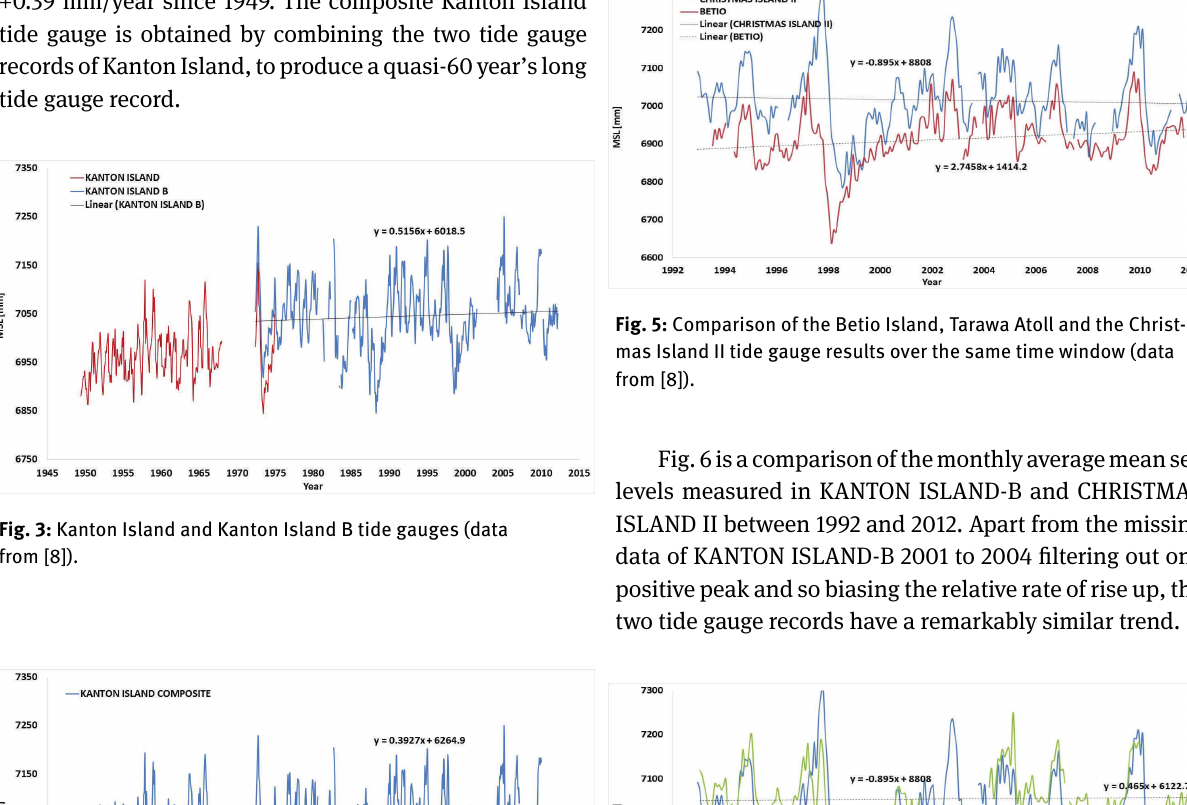
Fig. 4: Kanton Island composite tide gauges (data from [8]). The Betio result [2] is not only due to the start of the record at a particularly low level. Fig. 5 is a comparison of the monthly average mean sea levels measured in BETIO and CHRISTMAS ISLAND II between 1992 and 2012. The two tide gauges are run under different managements.